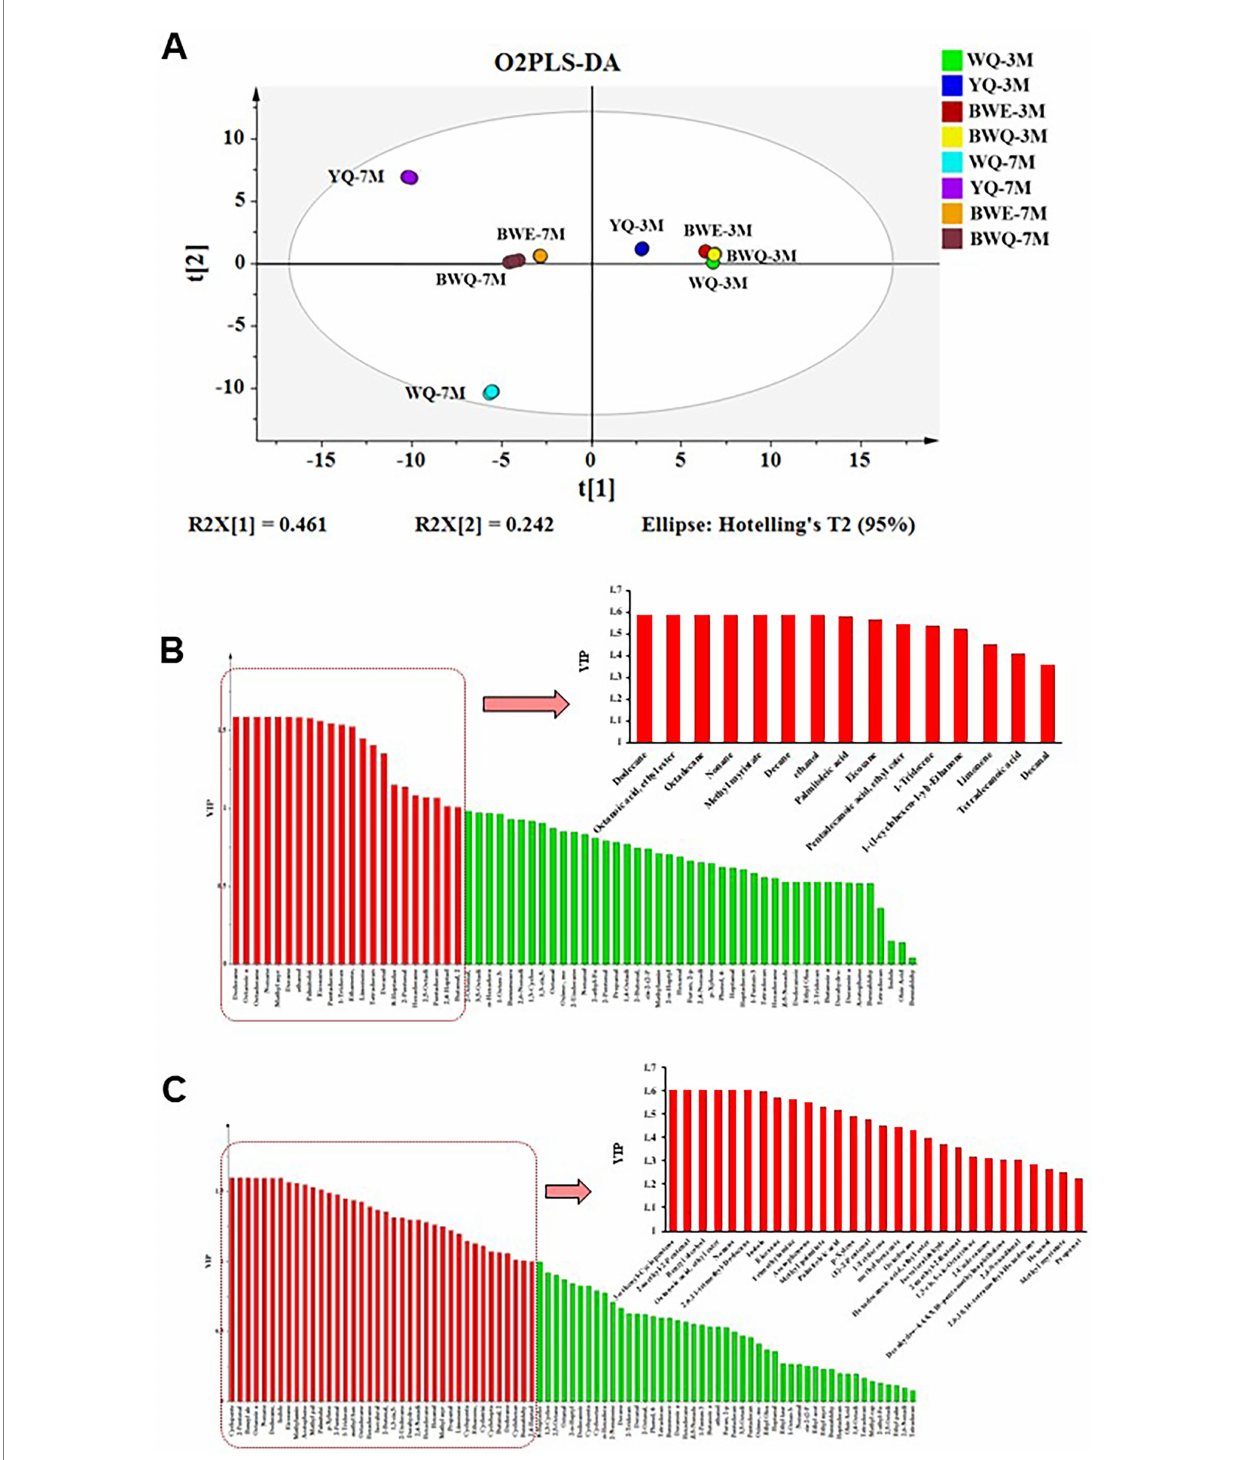
FIGURE 1 Detection of the differential flavor substances among WQ, YQ, BWQ, and BWE fish sauces at early (3 M) and late (7 M) fermentation. (A) O2PLS-DA model. (B) Major differential compounds among four fish sauces in the early fermented stage by VIP values. (C) Major differential compounds among four fish sauces in the late fermented stage by VIP